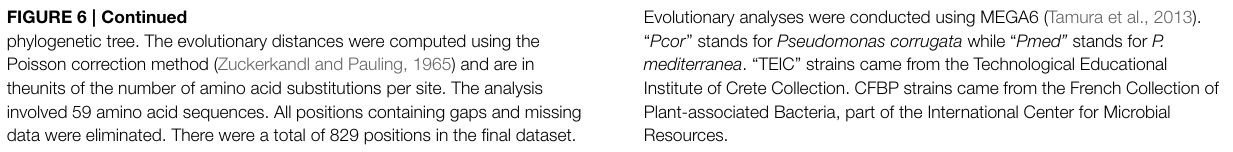
Evolutionary analyses were conducted using MEGA6 (Tamura et al., 2013). “ Pcor ” stands for Pseudomonas corrugata while “ Pmed” stands for